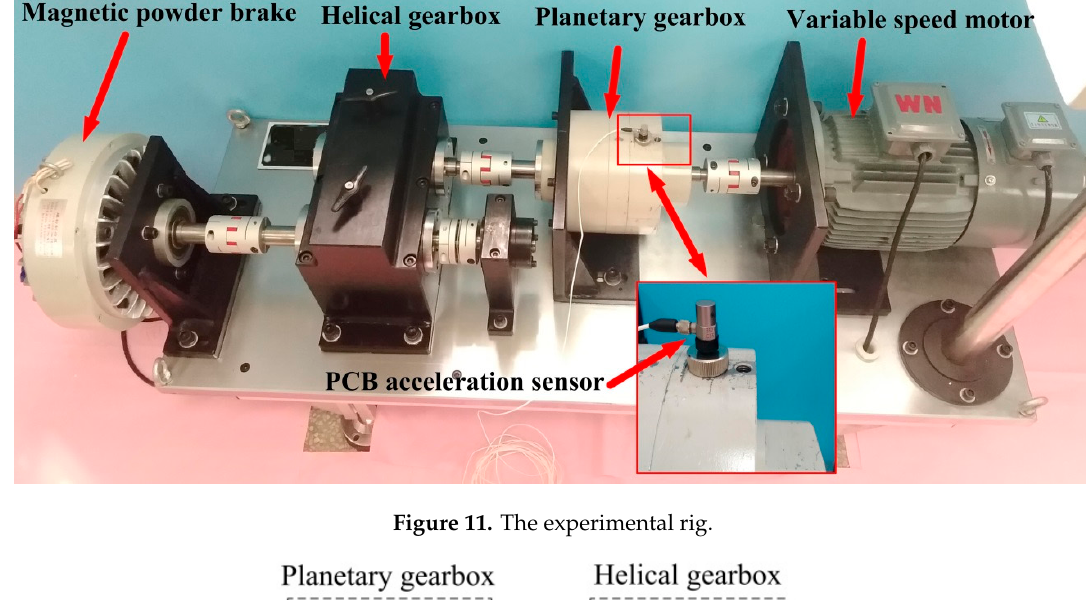
Figure 11. The experimental rig.